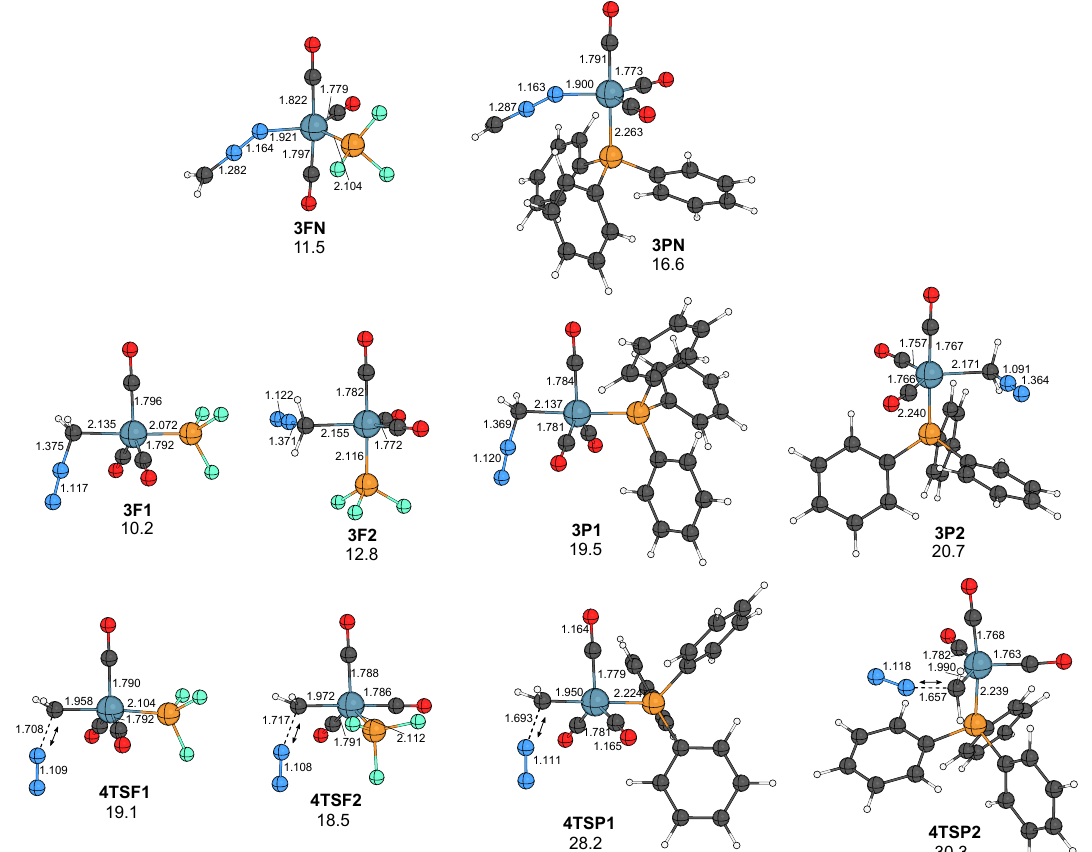
Figure 3. Computed minimum structures associated with the diazo coordination and activation steps, as well as transition states for the dinitrogen extrusion step. Bond distances are in Å and Gibbs free energy values are given in kcal/mol. Free energies are relative to 1F and 1P